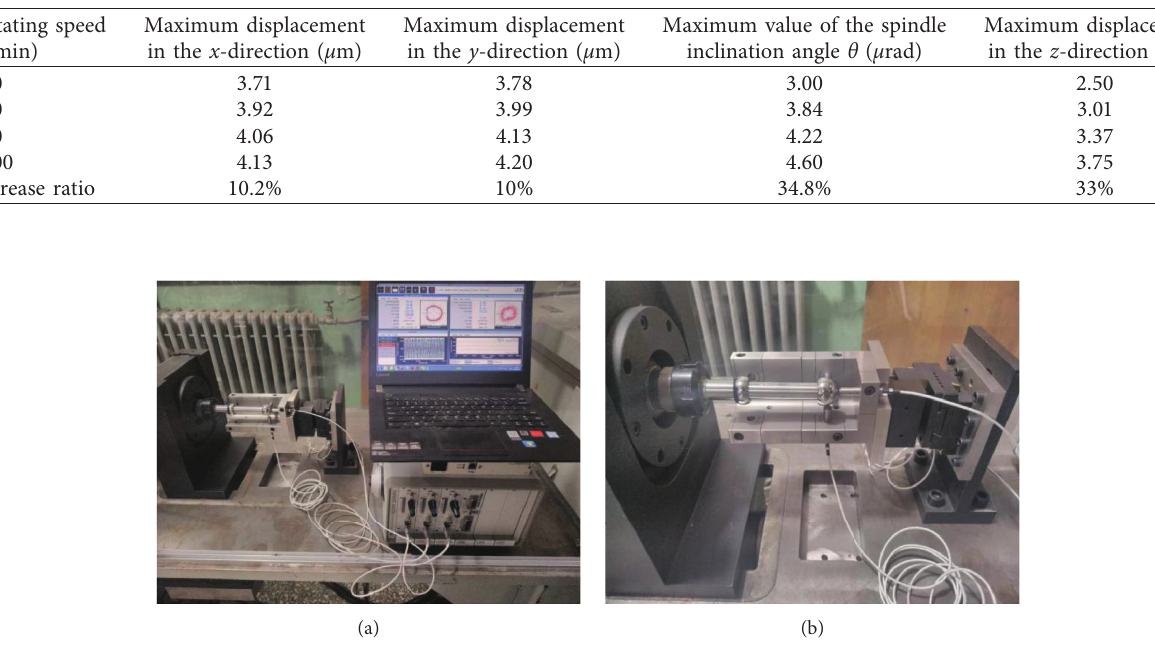
Table 2: Maximum value of motion error at four different